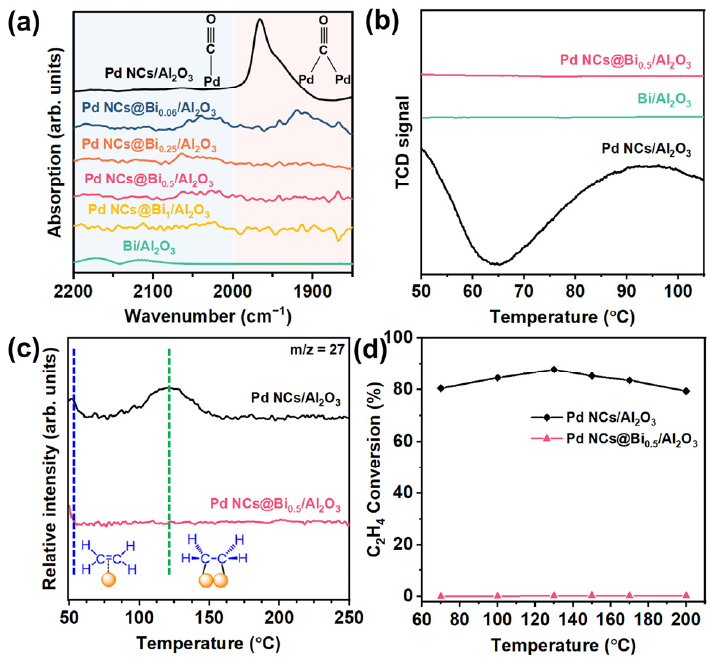
Figure 4. Study on reaction mechanism. ( a ) Infrared spectroscopy of CO adsorption, ( b ) H 2 − TPR profiles of Pd NCs/Al 2 O 3 , Bi/Al 2 O 3 and Pd NCs@Bi 0.5 /Al 2 O 3 catalysts, ( c ) C 2 H 4 − TPD profiles of Pd NCs/Al 2 O 3 and Pd NCs@Bi 0.5 /Al 2 O 3 catalysts, ( d ) C 2 H 4 conversion as a function of reaction temperature. (Reaction conditions: space velocity of 120,000 mL h − 1 g − 1 and reactant gases: 1.0 vol % C 2 H 4 , 20.0 vol % H 2 and 79 vol % N 2 ).